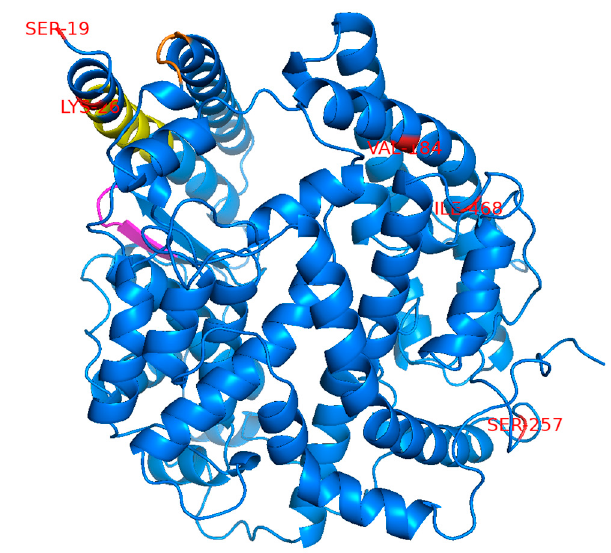
Figure 1. Mapping of the amino acid residues corresponding to the selected SNPs used in this study. The positions of the amino acid residues corresponding to the selected SNPs are marked in red on the crystal structure of ACE2 (1R42). Three amino acid positions (N637, L656, and N720) are not shown here because the regions containing these amino acids are not present in this crystal structure. The three separate regions reported to be important for binding to SARS-CoV-S are colored in yellow, magenta, and